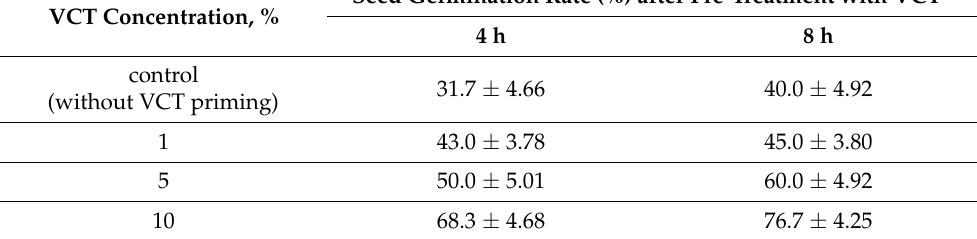
Table 1. Wild S. tau-saghyz seed germination following 4 and 8 h seed pre-treatment with 1, 5, and 10% VCT.